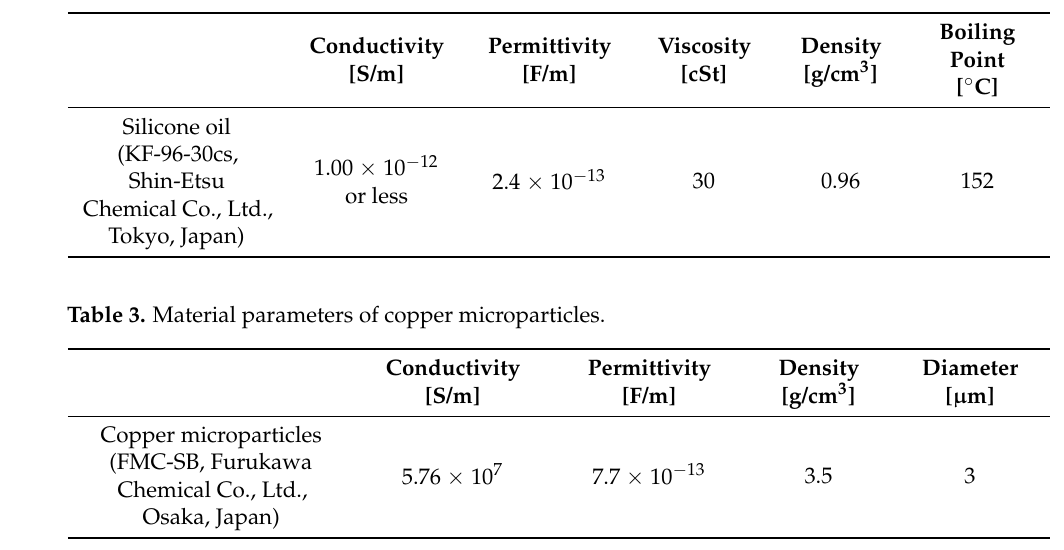
Table 2. Material parameters of silicone oil.